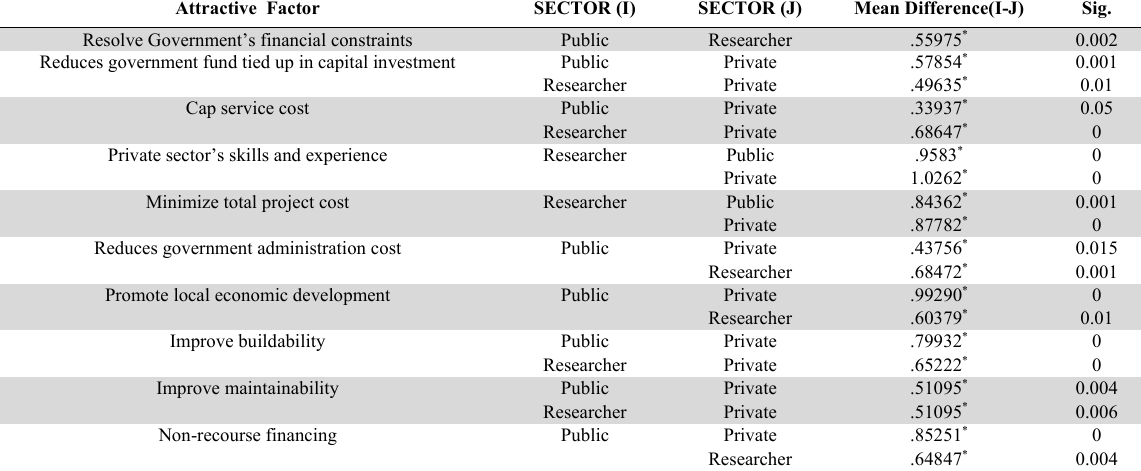
Post Hoc Test for Attractive factors with